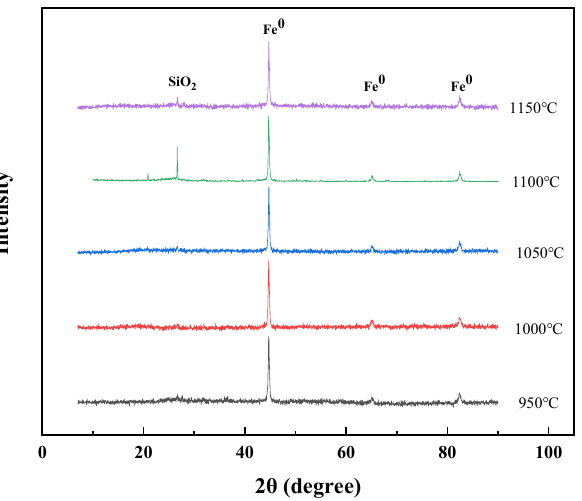
Figure 12. XRD pa tt erns of fi llers at di ff erent sintering temperatures. Figure 12. XRD patterns of fillers at different sintering